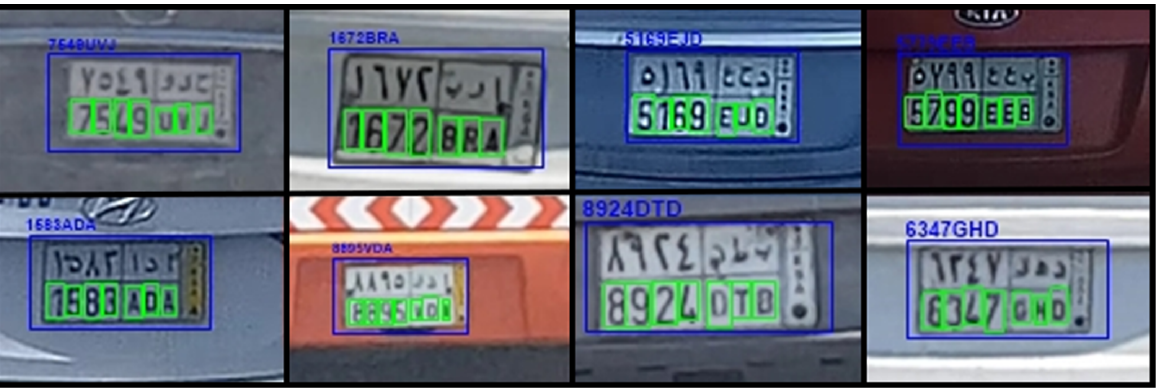
Figure 20. Recognition results of traffic-based LPs.